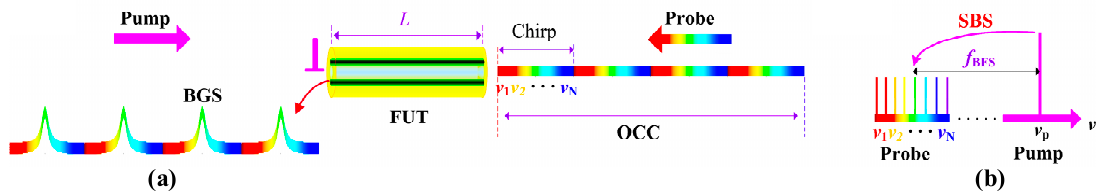
Figure 14. The operation principle of the OCC-BOTDA [1]. ( a ) The time-domain relationship and ( b ) the frequency-domain relationship.